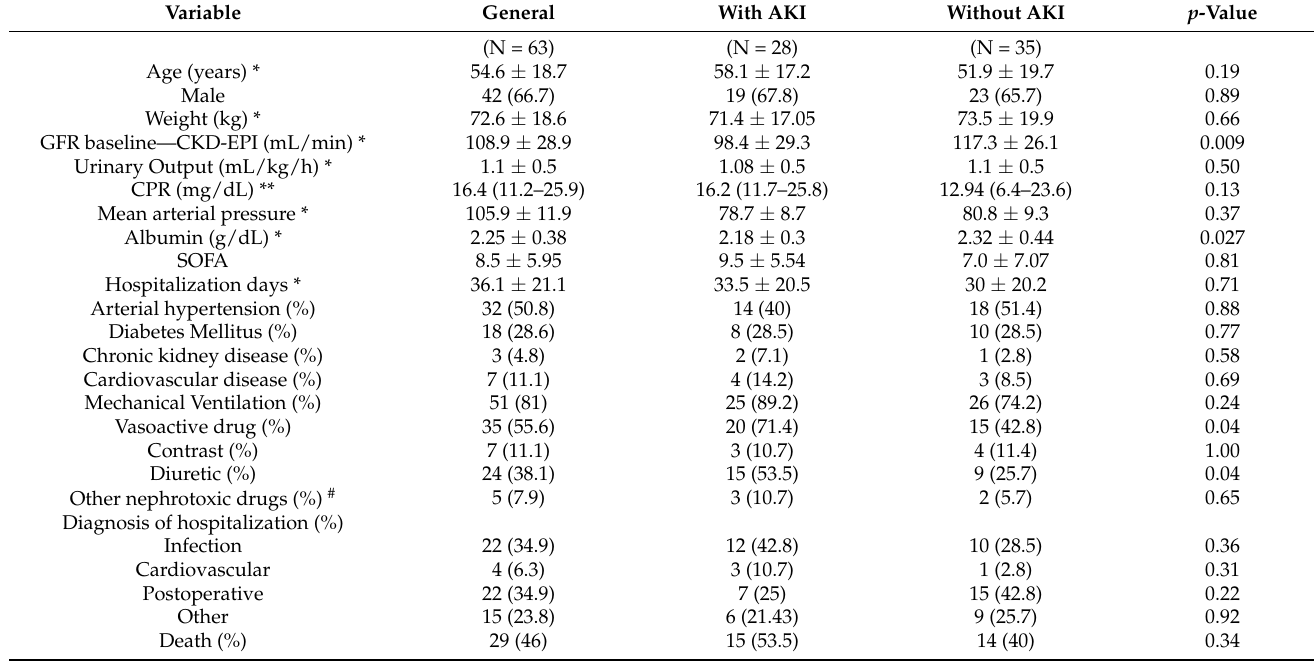
Table 1. Clinical and laboratory characteristics of patients hospitalized in an intensive care unit, using vancomycin for the presence or absence of AKI.